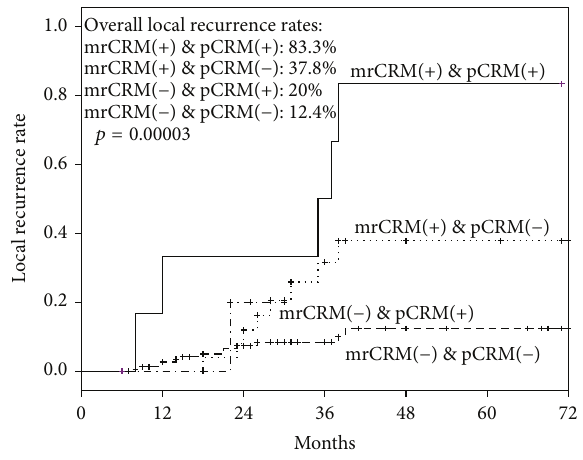
Figure 3: Kaplan-Meier survival plots for time to local recurrence in patients in groups of mrCRM(+) & pCRM(+), mrCRM(+) & pCRM( − ), mrCRM( − ) & pCRM(+), and mrCRM( − ) & pCRM( − ).